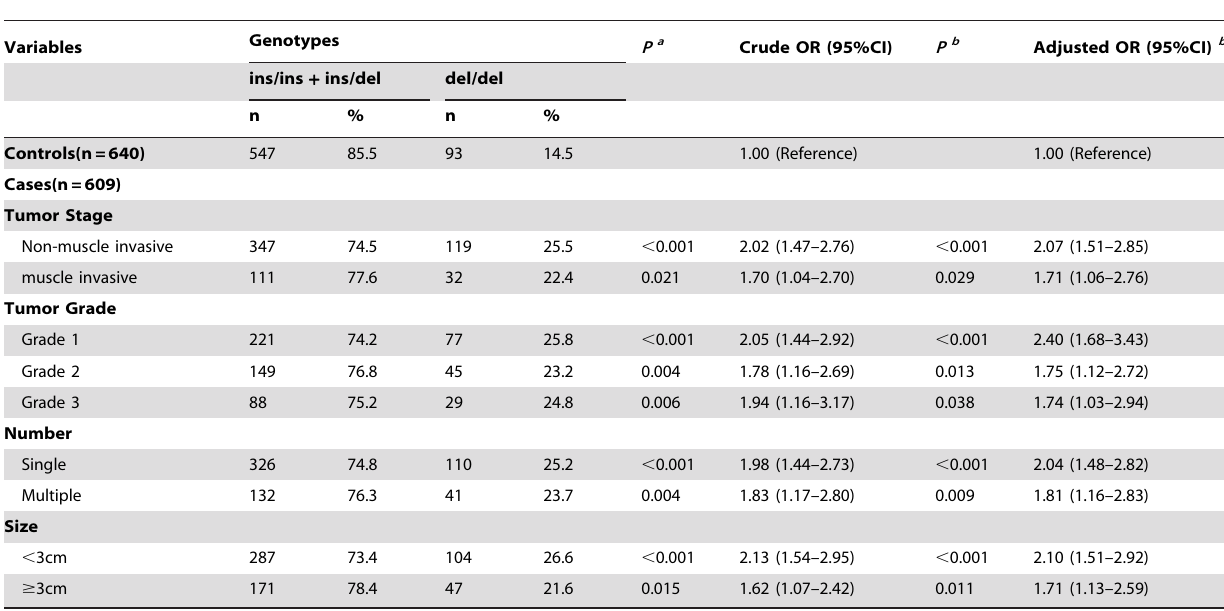
Table 4. The associations between NFKB1 promoter –94 ins/del ATTG polymorphism and the development of bladder cancer.